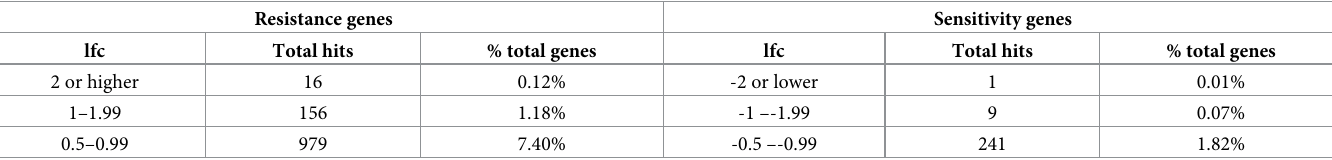
Table 1. Summary of survival screen